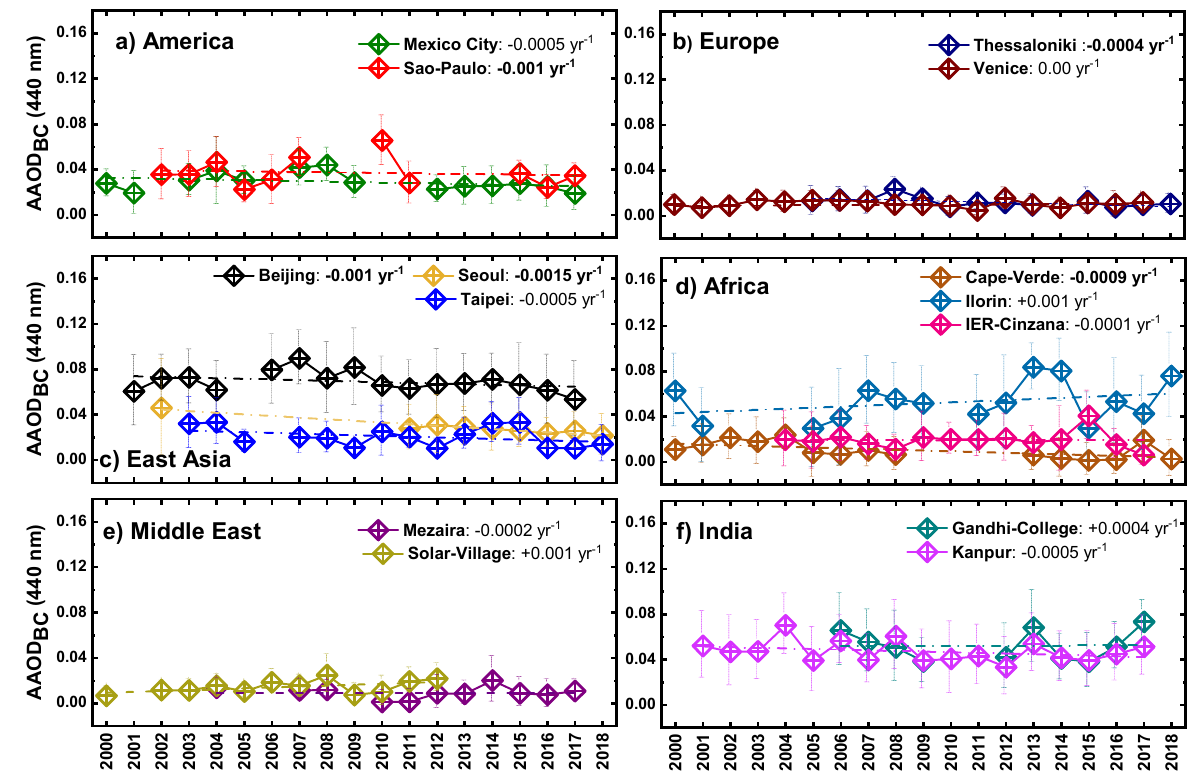
Figure 3. Variations of annual mean AAOD BC at 440 nm from 2000 to 2018 at fourteen sites. Error bars represent the standard deviation of the annual averages. (units AAOD BC yr − 1 ).